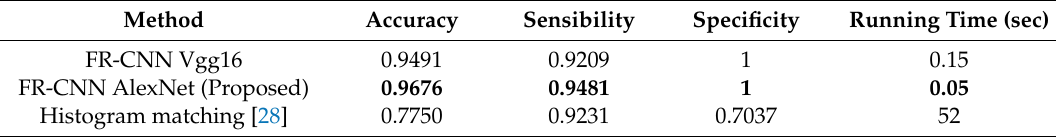
Table 4. OD detection performance comparison among three methods using DRIMBD dataset